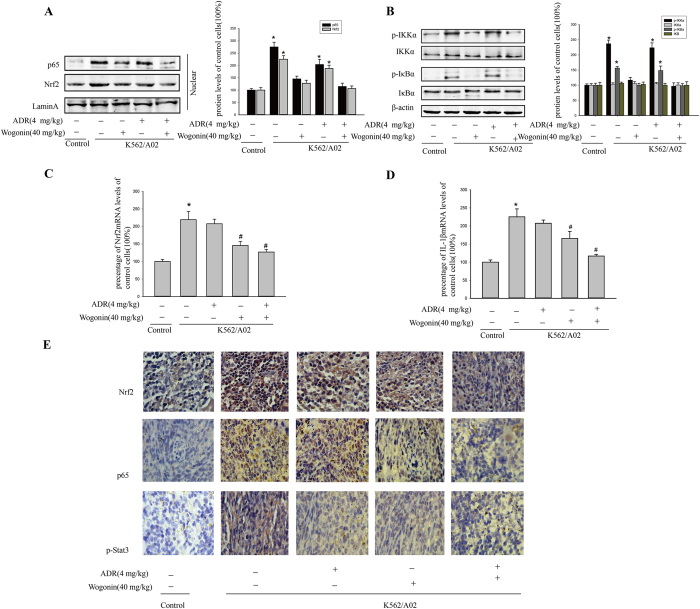
Wogonin combined with ADR treatment against leukemic cells by suppressing Stat3/Nrf2 pathway in vivo.(A) The expression of nuclear protein pY705-Stat3, p65 and Nrf2 were examined by Western blot assays in leukemic cells. *p < 0.05 compared with control. #p < 0.05 compared with K562/A02 group. (B) The ratio of p-IkBα/IkBα and p-IKKα/IKKα was analyzed by Western blot in leukemic cells. *p < 0.05 compared with control. (C) Levels of Nrf2 mRNA in untreated or treated group in leukemic cells were determined by RT-PCR. *p < 0.05 compared with control. #p < 0.05 compared with K562/A02 group. (D) Levels of IL-1βmRNA in untreated or treated group were determined by RT-PCR. *p < 0.05 compared with control. #p < 0.05 compared with K562/A02 group. (E) Nuclear NF-κB p65 and Nrf2 expression in spleen were analyzed by using immunohistochemical staining. All results were represented as the mean ± SD of three independent experiments.